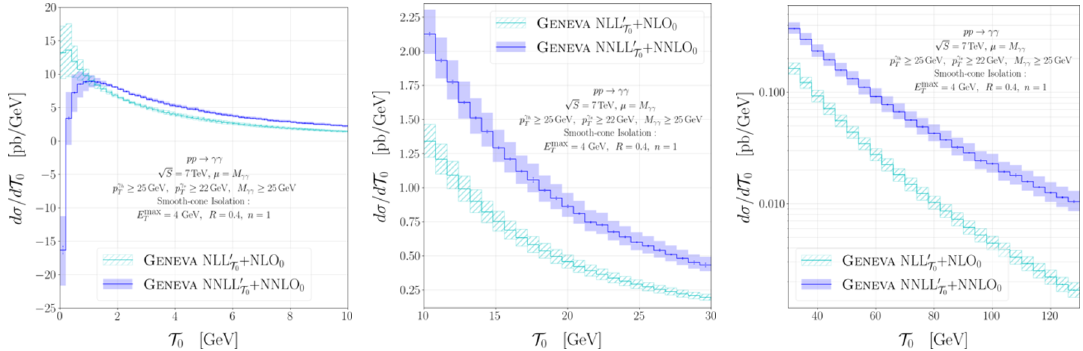
Figure 4 . Comparison between the NLL 0 +NLO and NNLL 0 +NNLO matched T 0 distributions in the peak (left), transition (centre) and tail (right)